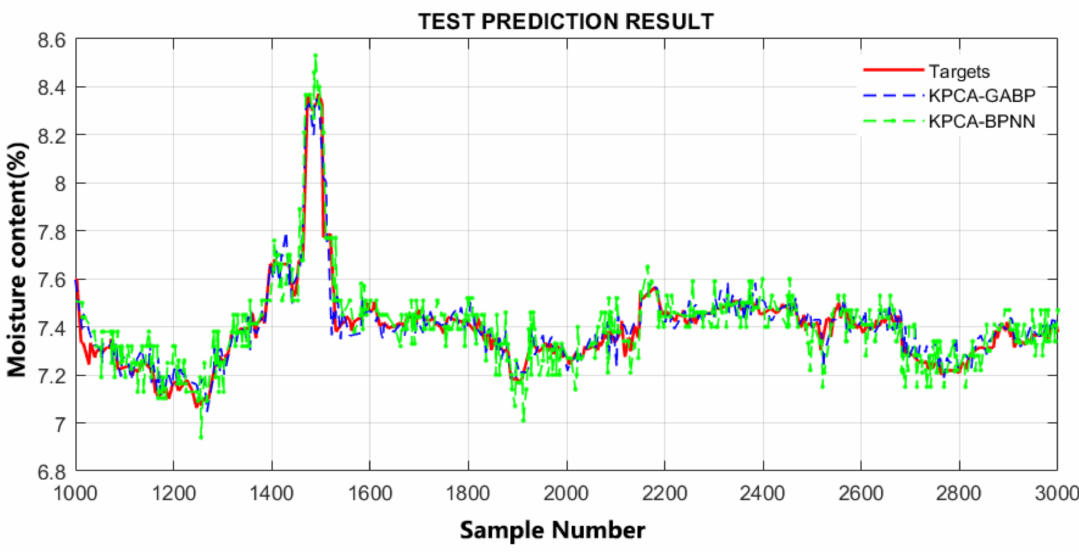
Figure 9. Prediction results of optimized water content model.